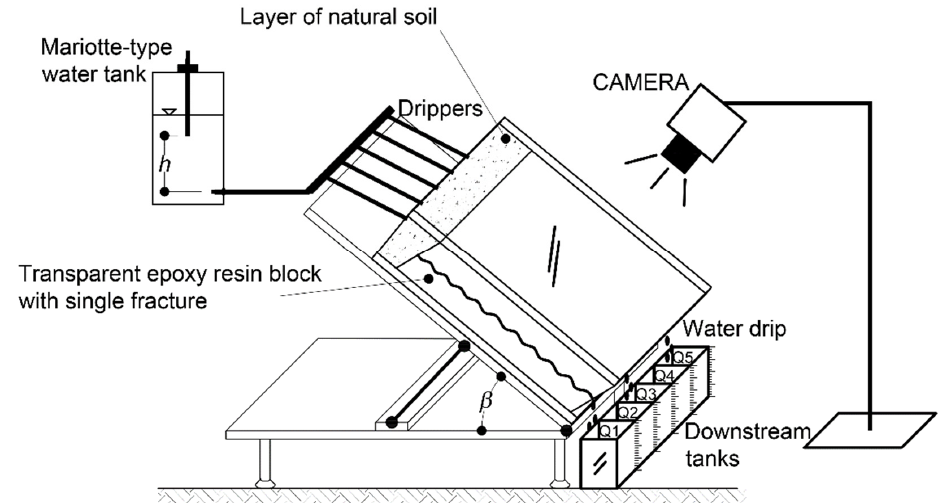
Figure 3. Experimental setup.